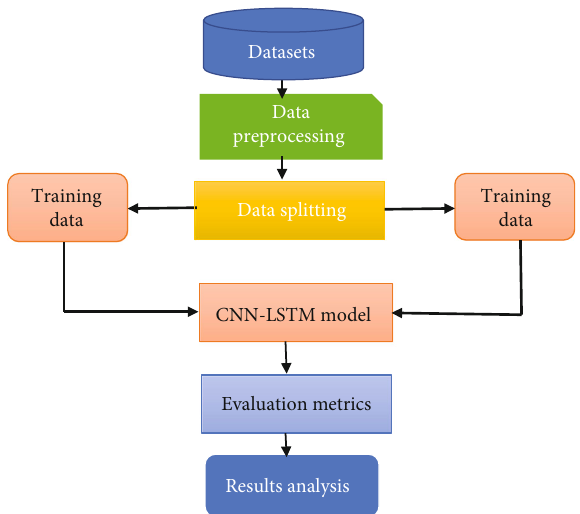
Figure 1: A Framework for the proposed